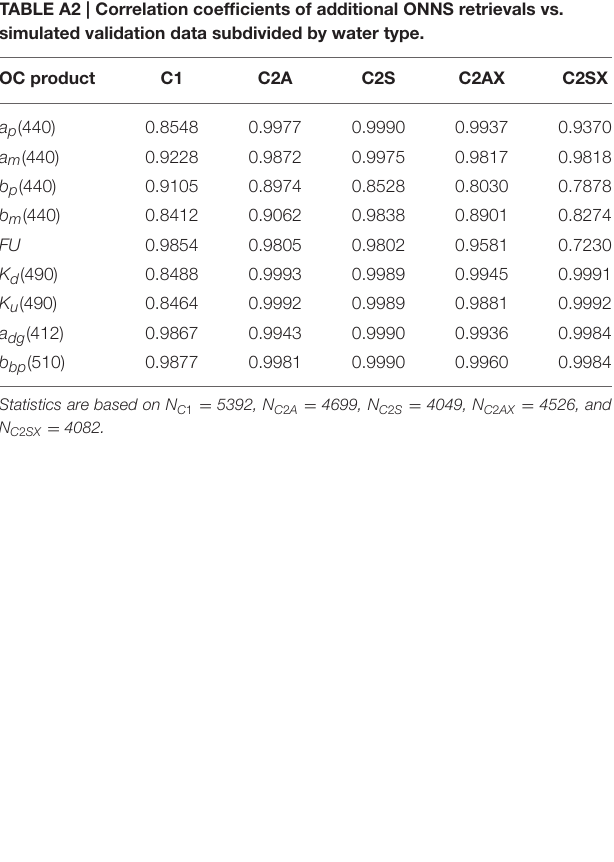
TABLE A2 | Correlation coefficients of additional ONNS retrievals vs. simulated validation data subdivided by water type.